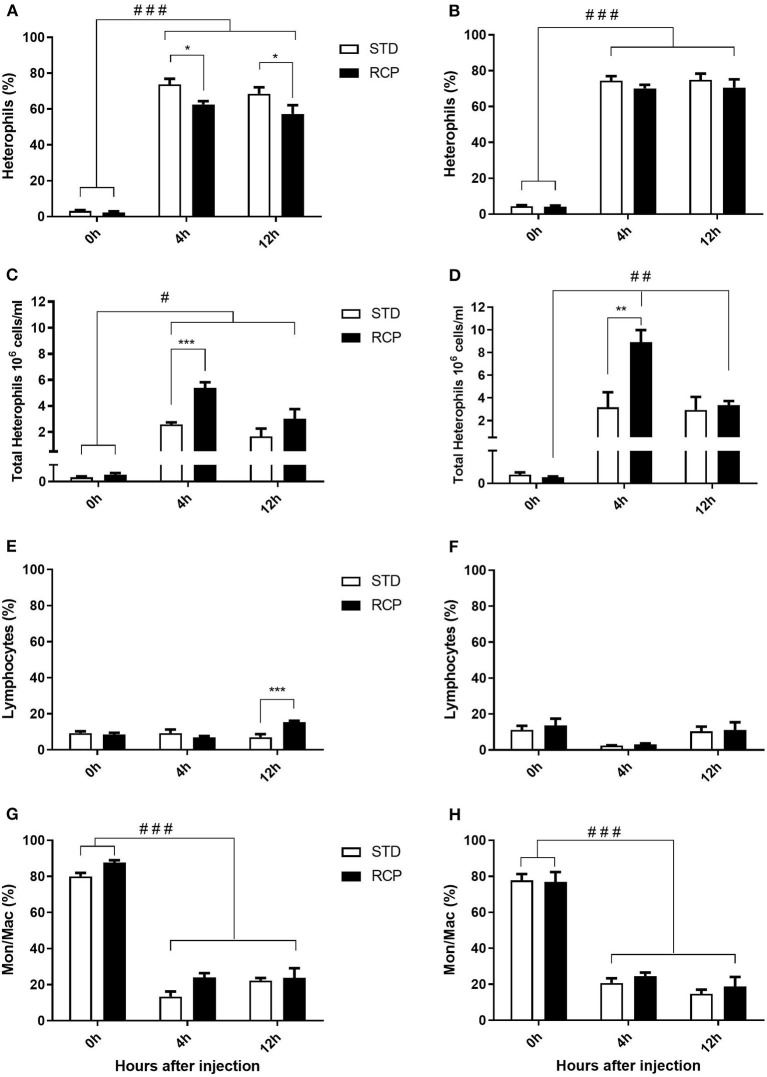
Impact of reduced crude protein diet on heterophil, lymphocyte, and monocyte/macrophage intra-abdominal leukocyte composition following an in vivo zymosan challenge. Changes to intra-abdominal heterophil percentages [d 14 (A); d 35 (B)] and absolute numbers [d 14 (C); d 35 (D)]. Parallel changes to the percentage of lymphocytes d 14 (E) and d 35 (F), and monocyte/macrophages d 14 (G) and d 35 (H). Heterophils are the dominant cells recruited after in vivo challenge and most affected by RCP diet (N = 5 for time 0 and 12, and N = 6 for time 4 h). *P < 0.05, **P < 0.01, and ***P < 0.001 between dietary treatments and #P < 0.05, ##P < 0.01, and ###P < 0.001 among different time points. RCP, Reduced Crude Protein; STD, Standard diet.